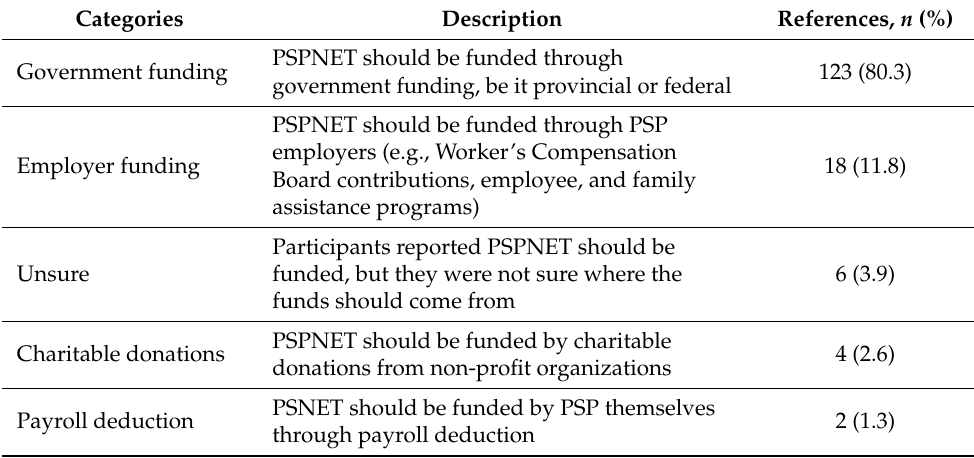
Table 6. Perceptions of how to best fund PSPNET ( n = 153).